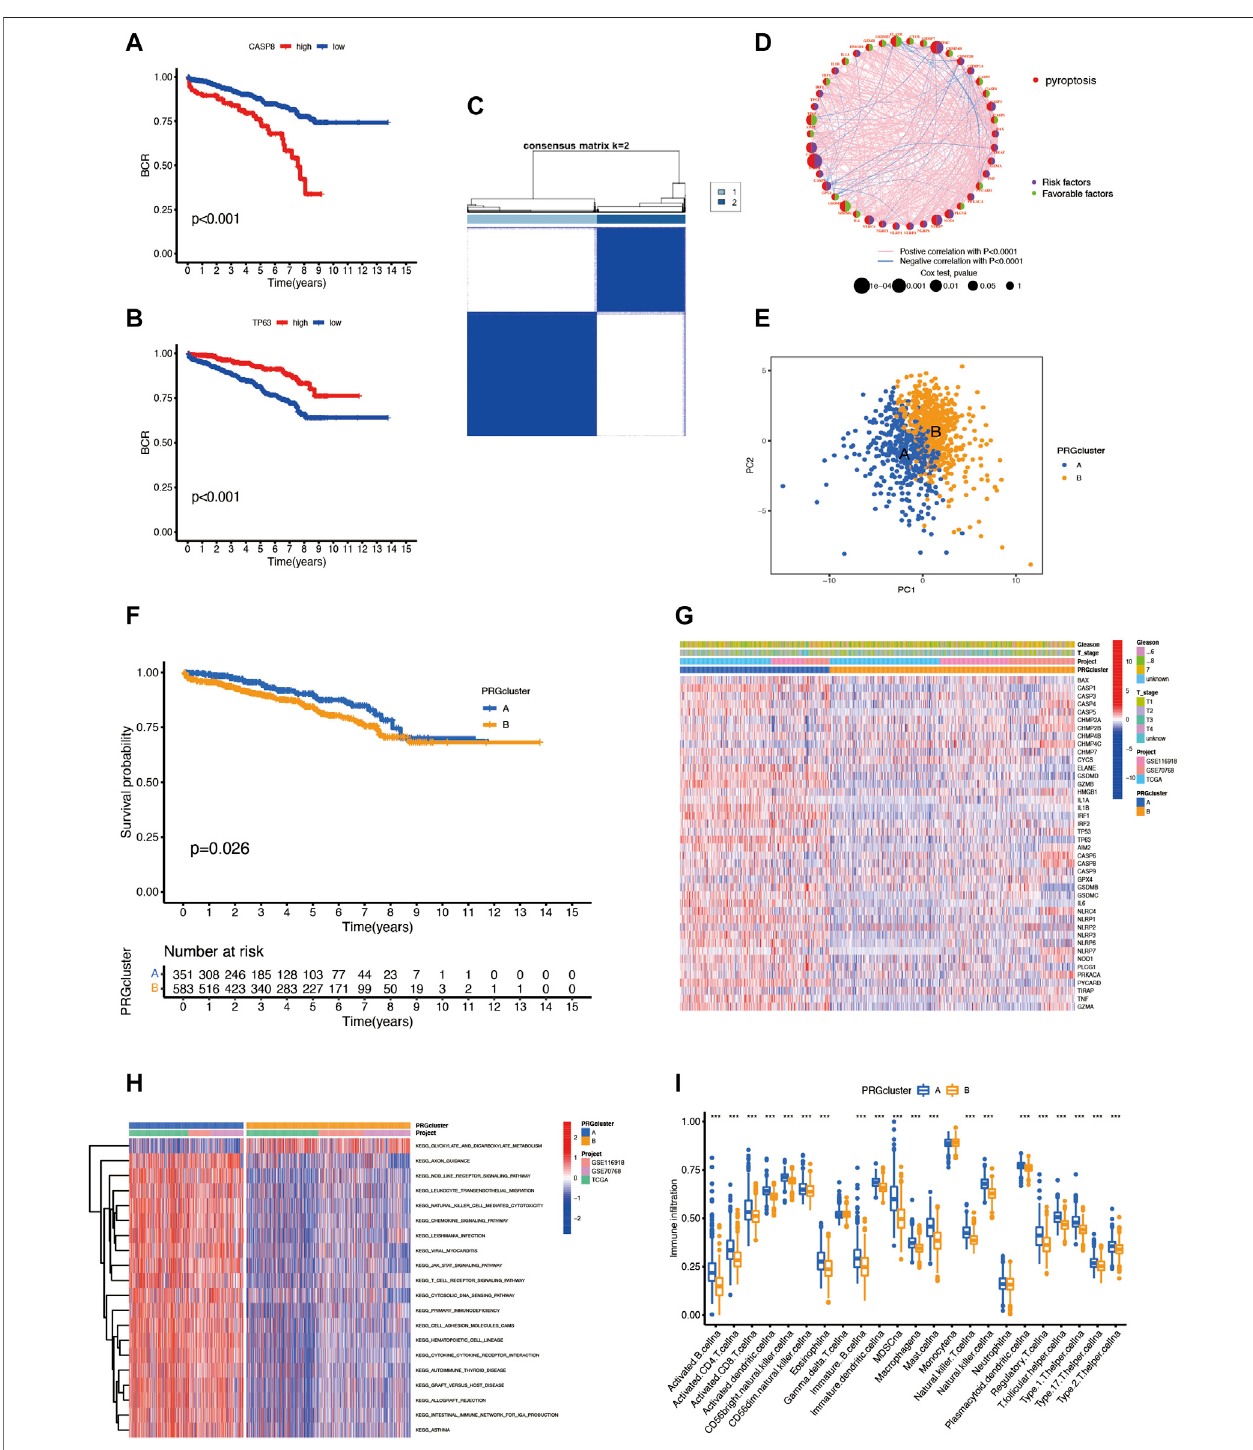
FIGURE2|(A,B) ThesurvivalanalysisofsomePRGs. (C) Consensusclusteringanalysisclassi fi espatientsintotwosubtypes. (D) Pyroptosisnetworkdiagram. (E) PCA of two clusters. (F) Prognosis difference between subtypes A and B. (G) The heatmap reveals the relationship between clinical features and different subtypes. (H) GSVA enrichment analysis between two subtypes. (I) Immune cell in fi ltrates between the two subtypes.